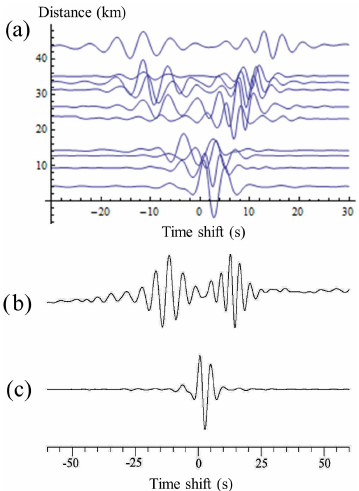
Figure 10. (a) Empirical Green’s functions calculated between sta- tion DF01 and all other stations of the DAFNE array. (b) EGF cal- culated for stations with the largest interstation distance (DF01 and DF12). (c) EGF calculated for stations with the smallest interstation distance (DF01 and DF09).